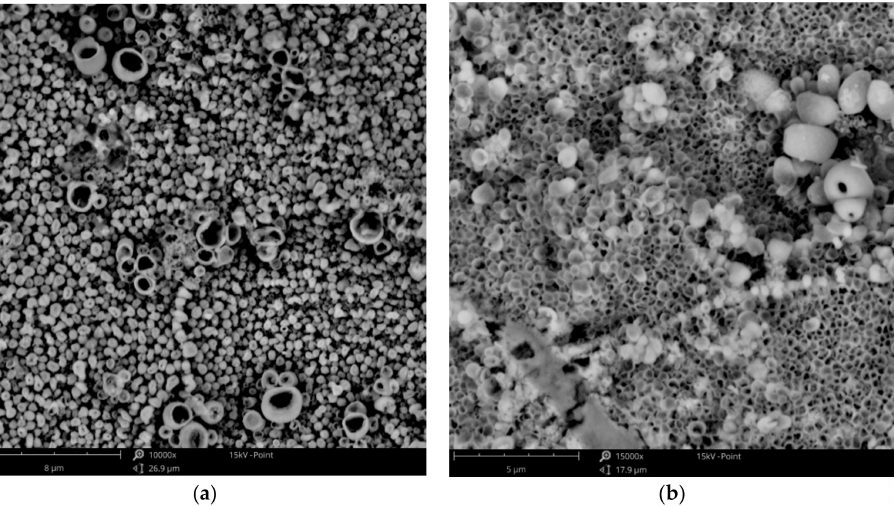
Figure 7. SEM images of the Cu-Zn coating electrodeposited in the CuZn-1 bath at a temperature of 100 ◦ C, at a current density of: ( a ) j c = 1.5 mA · cm − 2 ; ( b ) j c = 12 mA · cm − 2 .